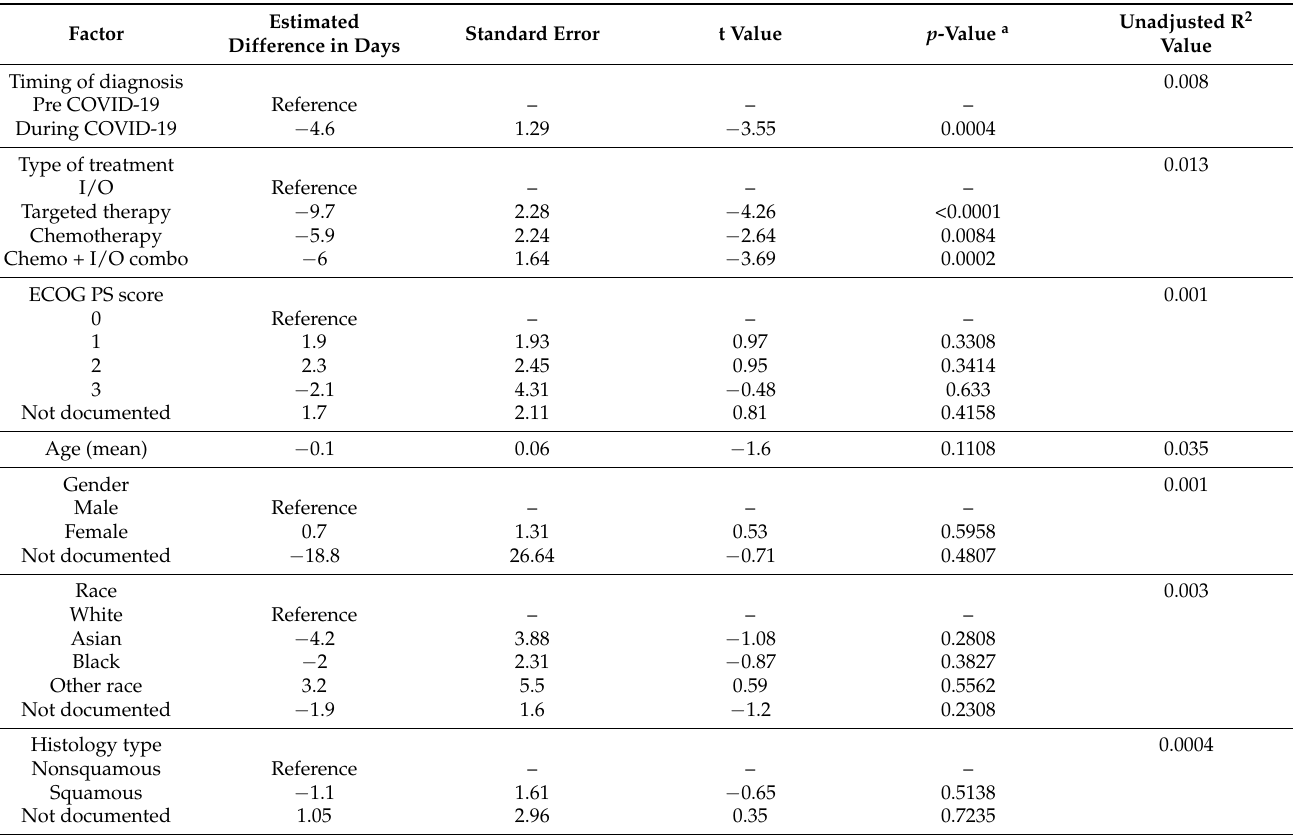
Table 3. Multivariate linear regression assessing association between timing of NSCLC diagnosis with time to treatment